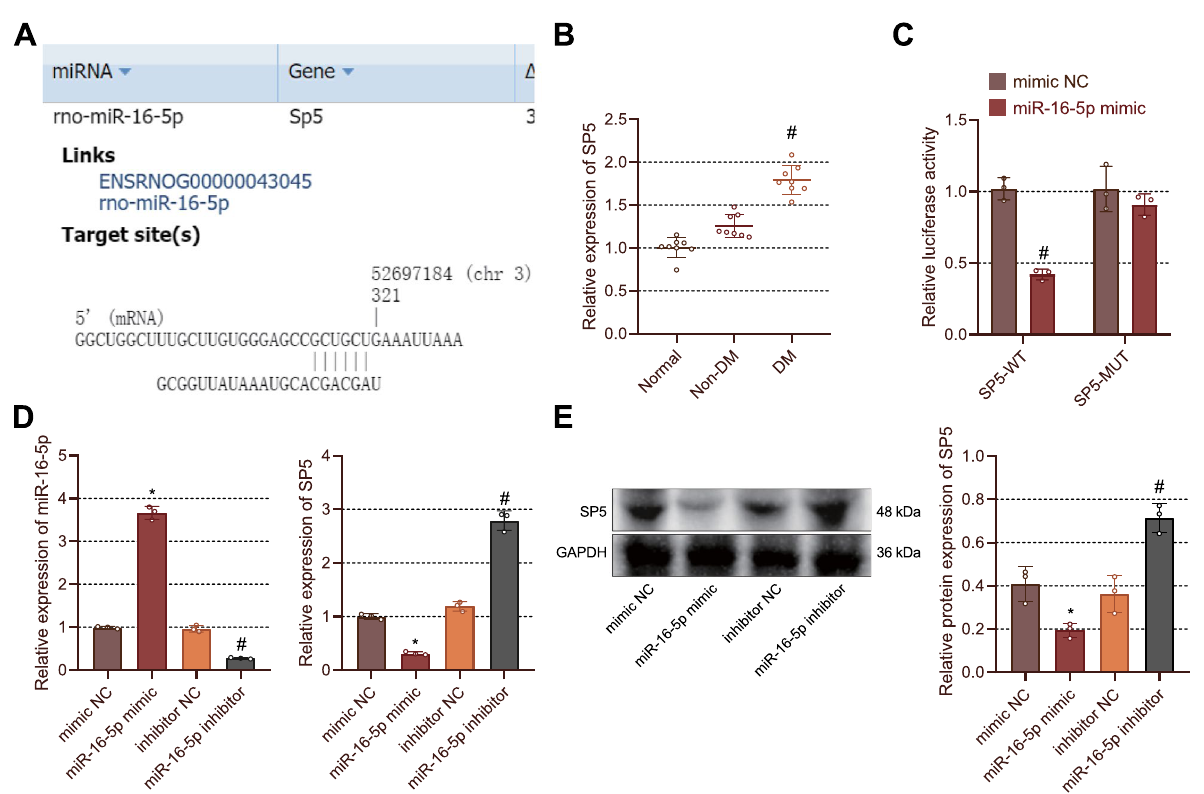
Fig. 5 SP5 is a target gene of miR-16-5p. A Binding sites between miR-16-5p and SP5 predicted by the starBase database. B RT-qPCR detection of SP5 expression in rat foot wound tissues of non-DM and DM rats. * p < 0.05 vs. normal rats; # p < 0.05 vs. non-DM rats. C The binding of miR-16-5p to SP5 in HEK293T cells validated by dual-luciferase reporter assay. # p < 0.05 vs. mimic NC-transfected HEK293T cells. D SP5 expression in fibroblasts transfected with miR-16-5p mimic or miR-16-5p inhibitor detected by RT-qPCR. * p < 0.05 vs. fibroblasts transfected with mimic NC; # p < 0.05 vs. fibroblasts transfected with inhibitor NC. E Western blots of SP5 protein in fibroblasts transfected with miR-16-5p mimic or miR-16-5p inhibitor. * p < 0.05 vs. fibroblasts transfected with mimic NC. # p < 0.05 vs. fibroblasts transfected with inhibitor NC. Cell experiments were repeated